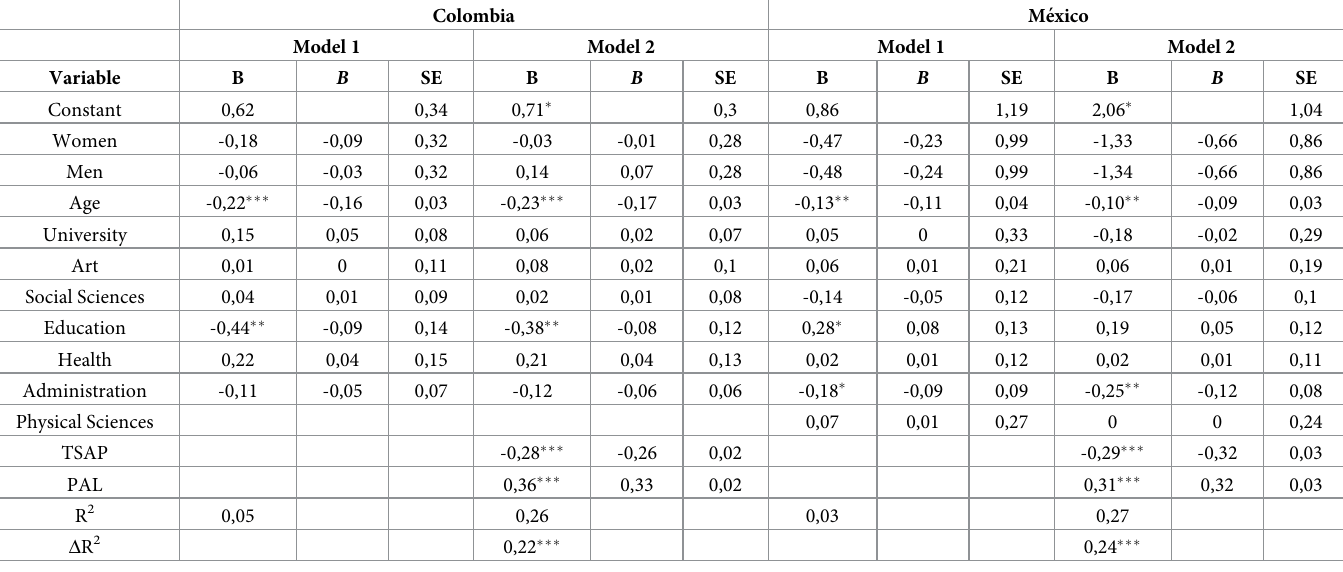
Table 6. Regression models in Colombia and